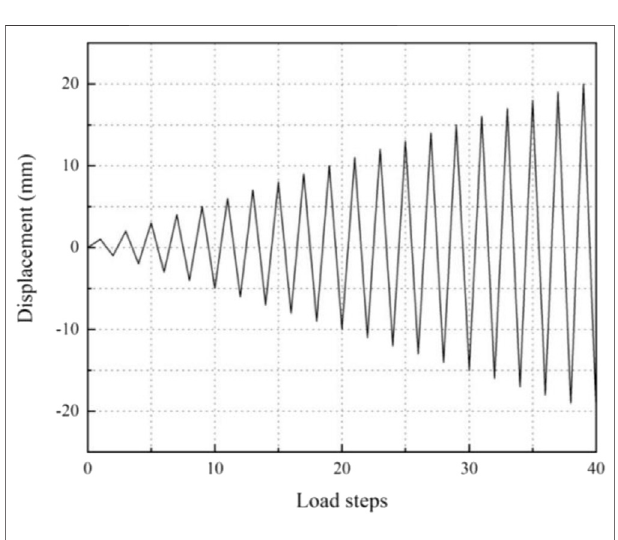
FIGURE 10 | Loading